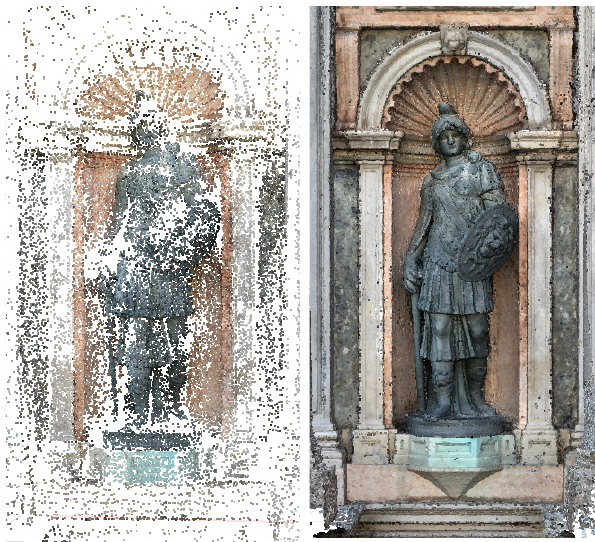
Figure 17. Tie points and dense cloud of the photogrammetric model of Pallas.